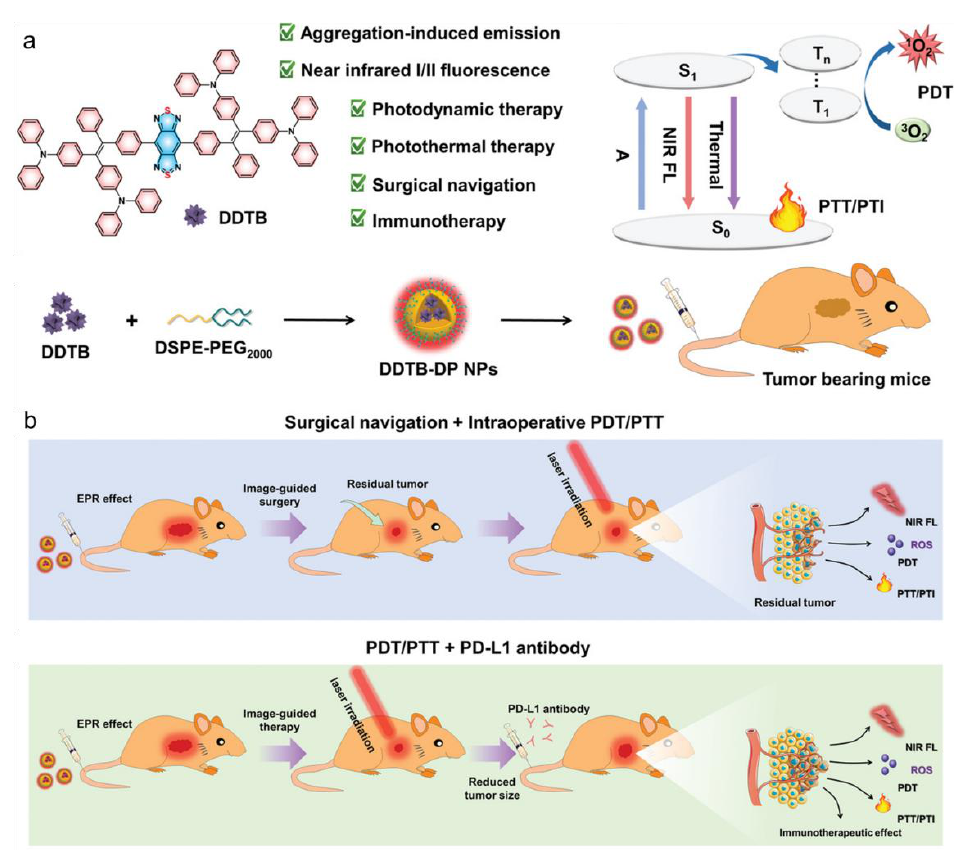
Figure 6. ( a ) Schematic illustration of chemical structure, NPs fabrication, and various photophysi- cal properties of DDTB-DP. ( b ) Schematic of the DDTB-DP NPs for NIR-II fluorescence imaging-guided surgery – PTT/PDT and immunotherapy of HeLa tumor-bearing mice (Reprinted with permission from Ref. [98]. Copyright 2021, Wiley-VCH GmbH).